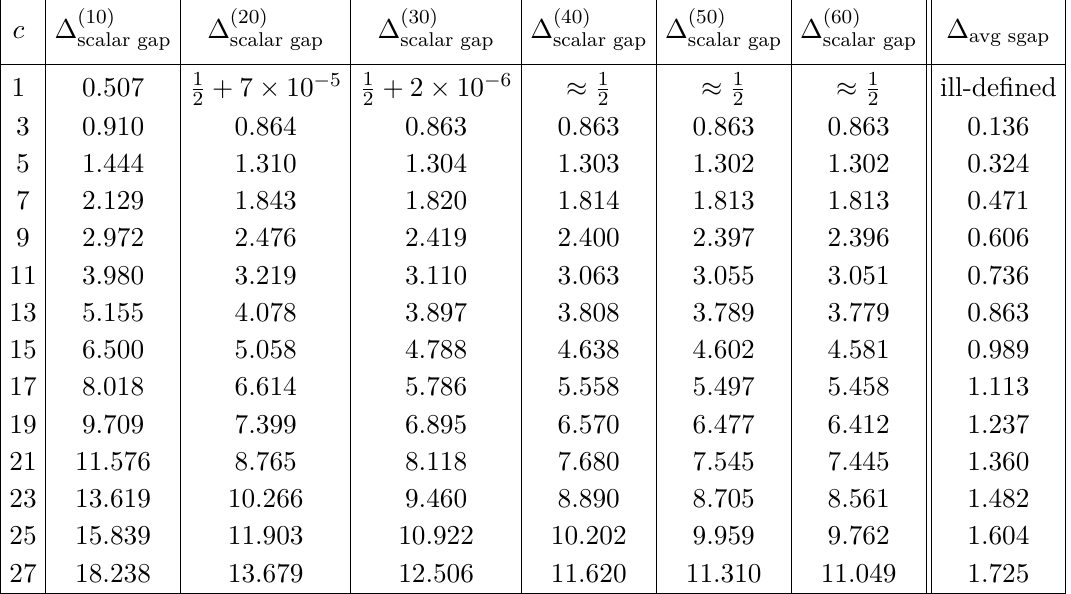
Table 1 . Upper bounds on the scalar gap from U(1) c CFTs with odd c ≤ 27 after taking up to 10 , 20 , · · · , 60 derivatives of our crossing equation (i.e. the maximum value of n in (3.39)) computed to three decimal places. We also compare it to the average Narain scalar gap, defined in (3.44) (though note that the optimal bound is different from the average). See figure 3 for a